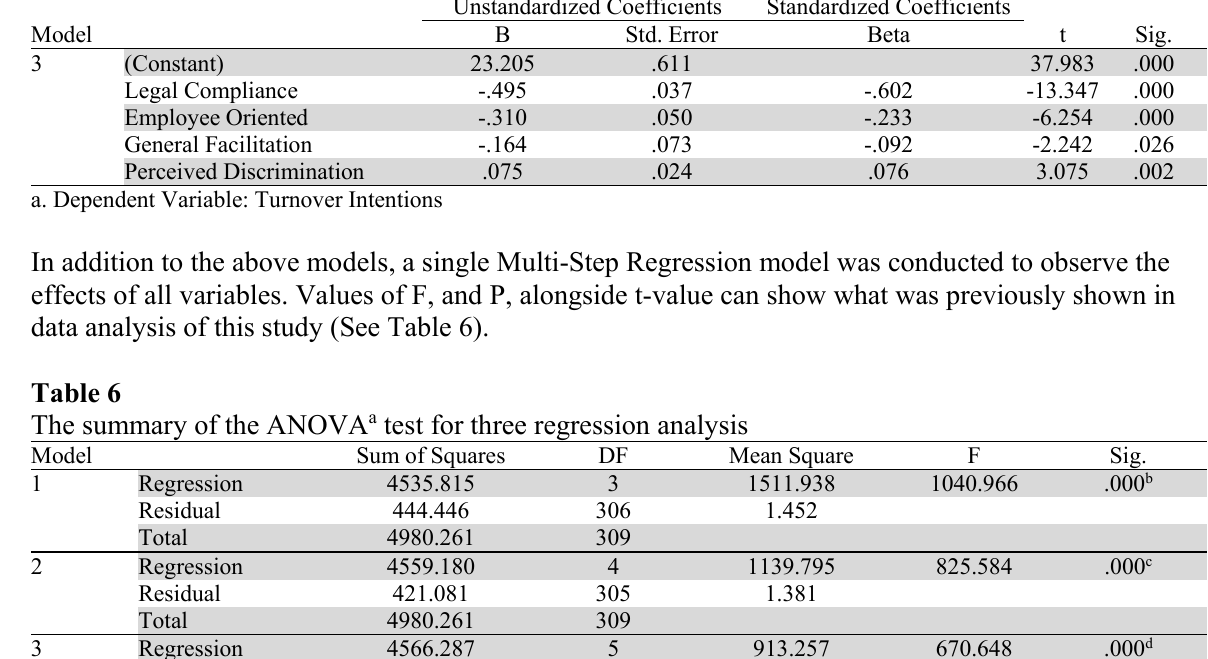
The results of regression analysis for the third hypothesis